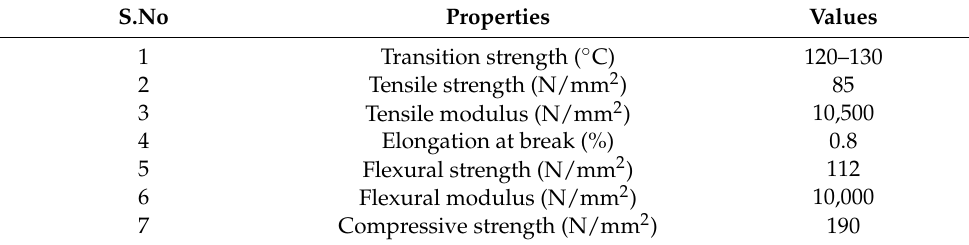
Table 2. PropertiesofEpoxy resin